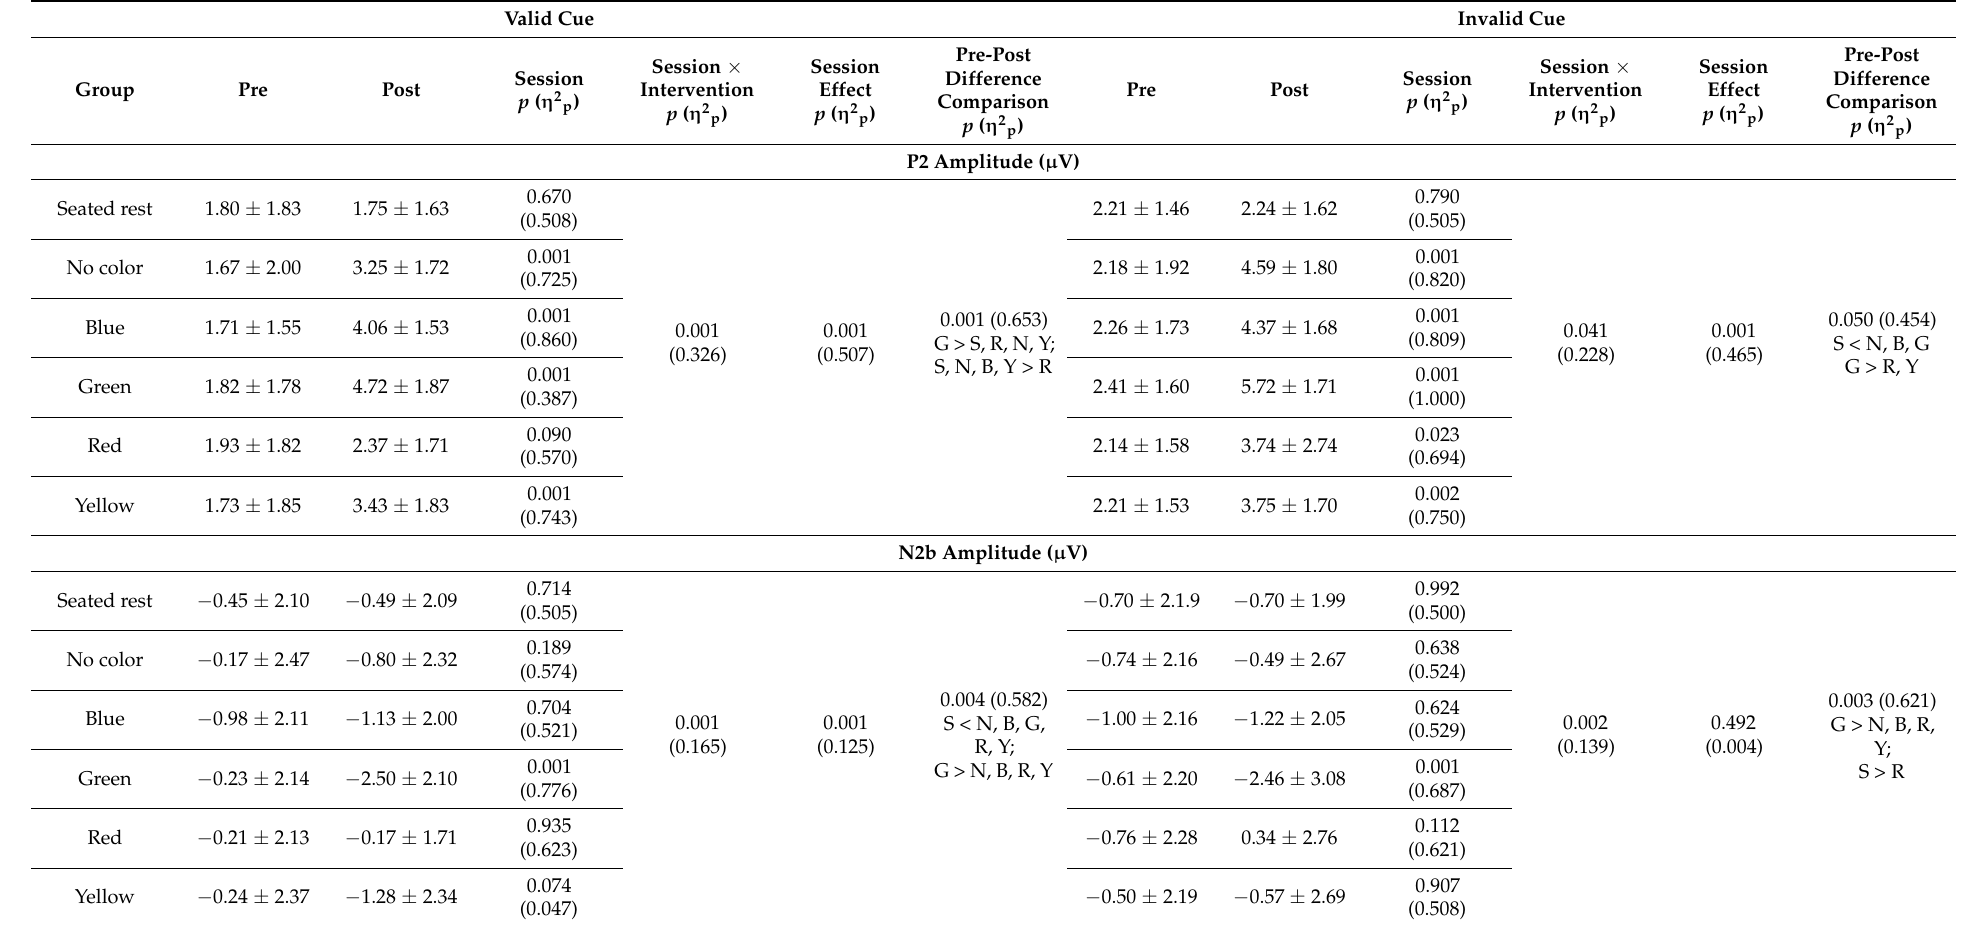
Table 2. Event-related potential on the Kanizsa Triangle Task for seated-rest and pre and post-exercise in five different